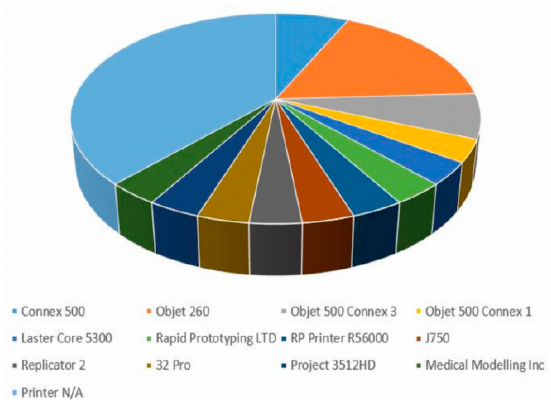
ff erent 3D-printer models / brands utilised based on the analysis of 27 Figure 2. Different 3D-printer models/brands utilised based on the analysis of 27 studies. Figure 2. Di